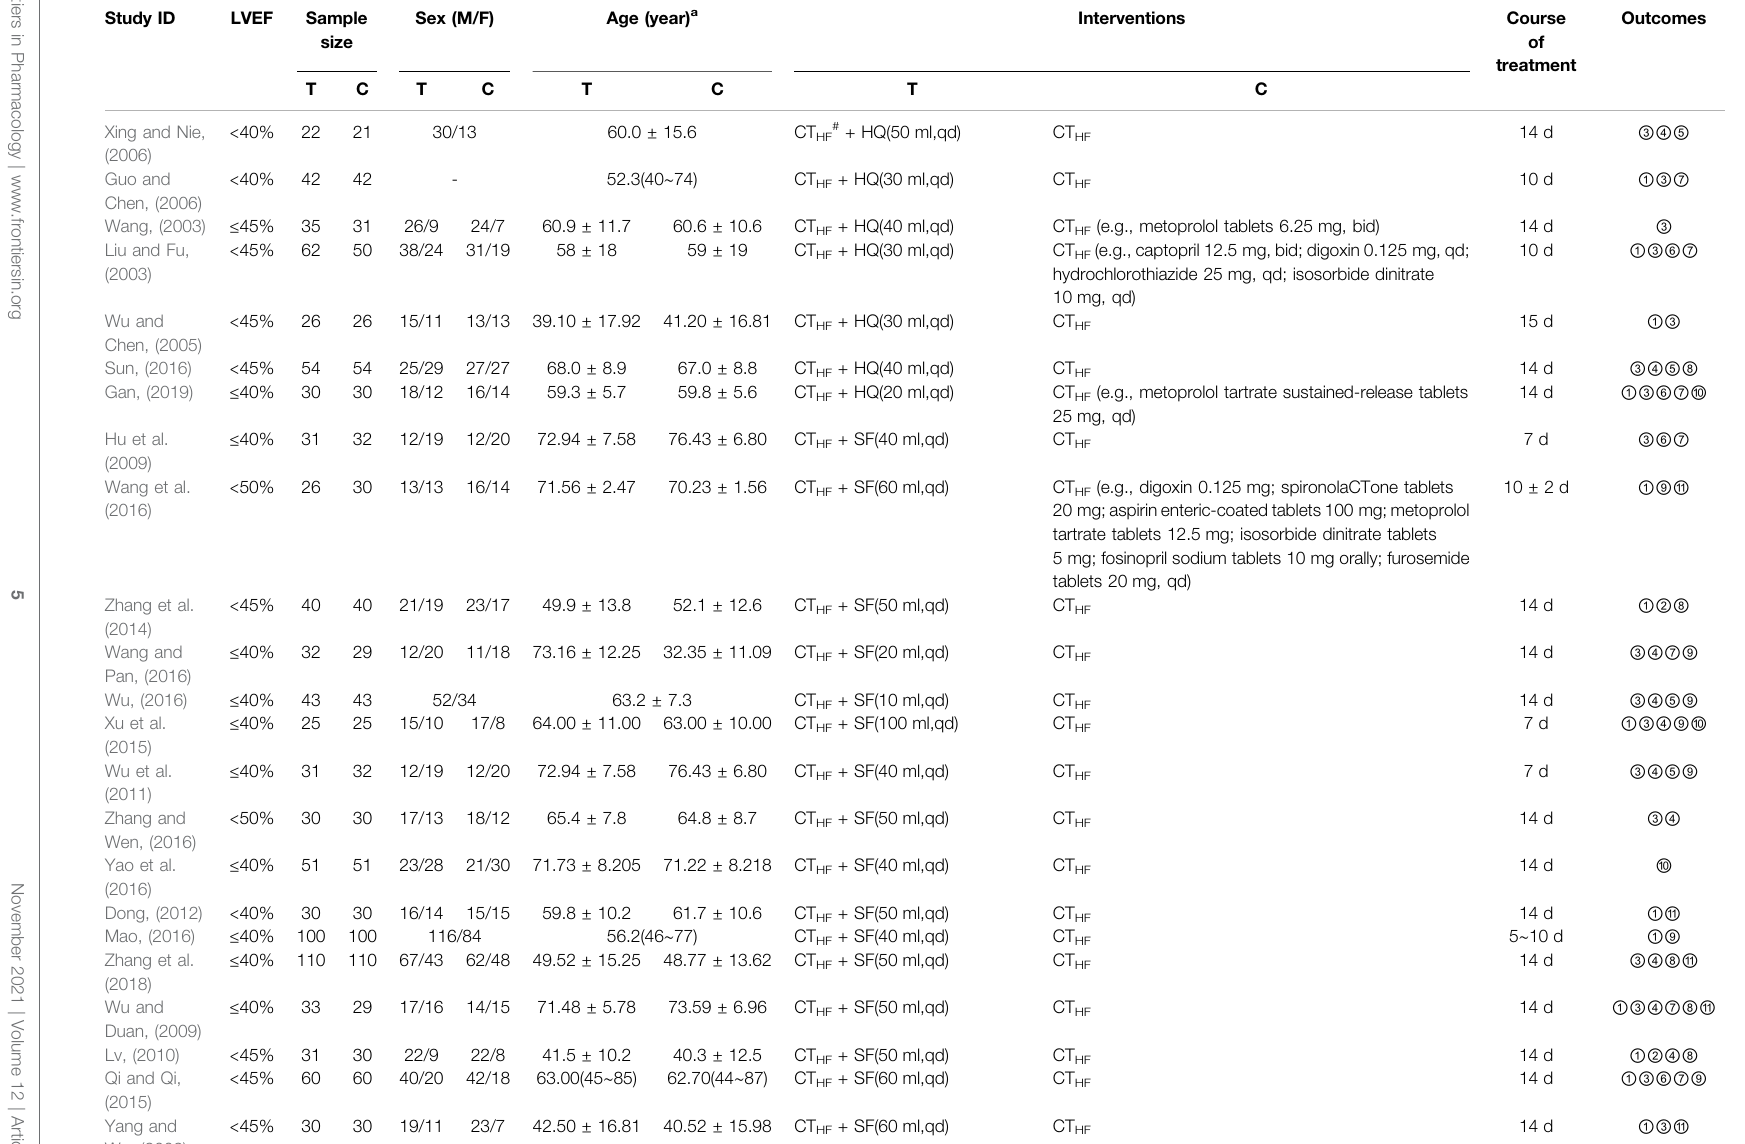
TABLE 1 | Characteristics of the studies included in this network